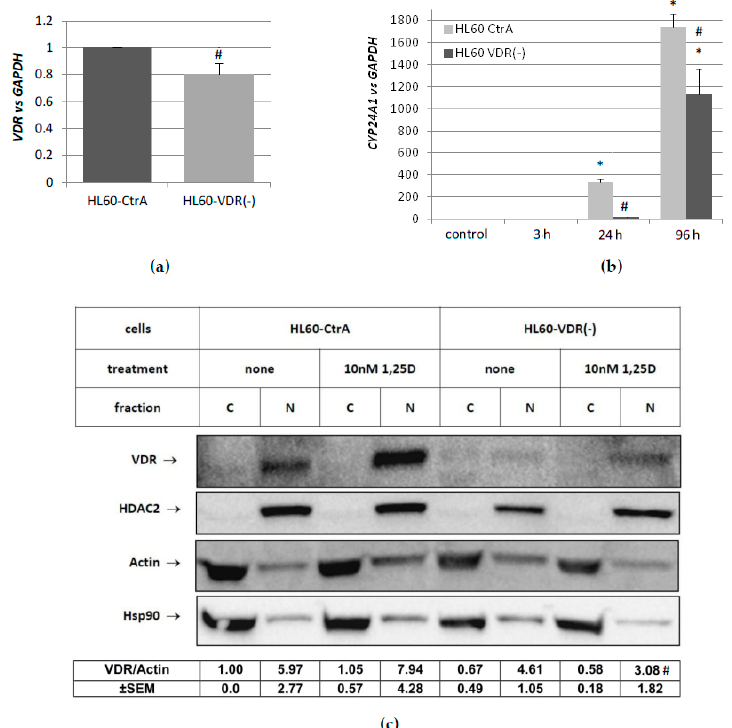
Figure 4. Generation of HL60 cells with reduced VDR expression. Constitutive expression of VDR gene in HL60-CtrA and HL60-VDR( − ) cells. Expression in HL60-CtrA was treated as calibrator ( a ). Expression of CYP24A1 was measured in both cell lines exposed to 10 nM 1,25D for different times ( b ). The levels of VDR protein were determined in the cytosol and nuclei of HL60-CtrA and HL60-VDR( − ) cells by western blots after 10 nM 1,25D stimulation for 24h (c). Cell lysates were tested while